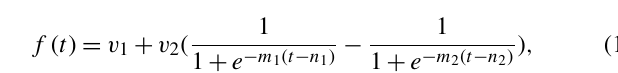
ing phenology indicators and their dynamics (Fig. S1 in the